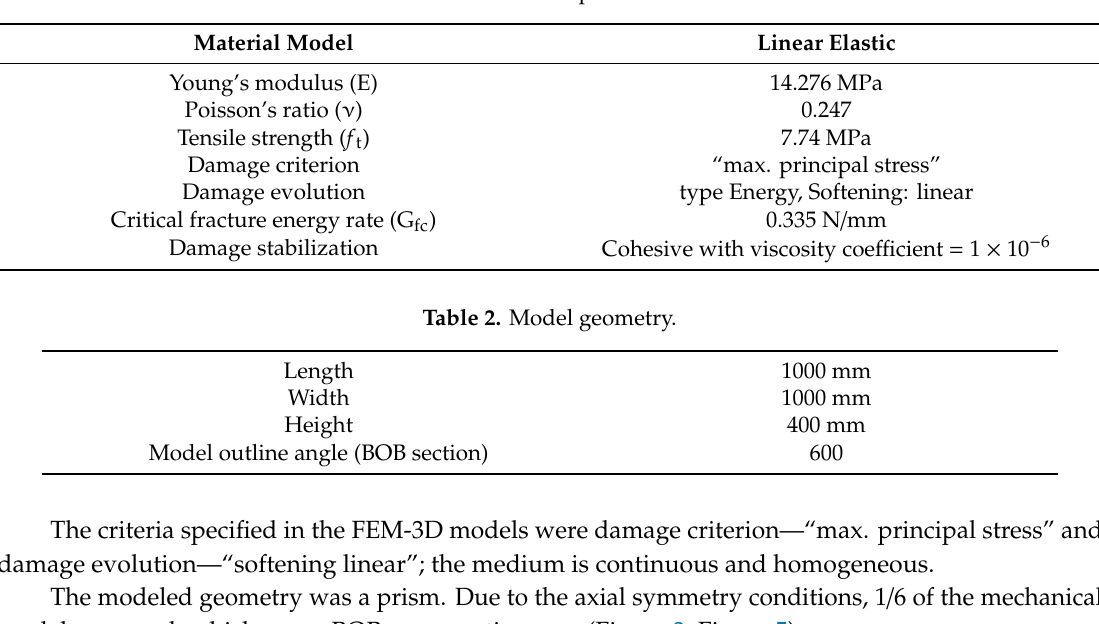
Table 1. Material parameters.